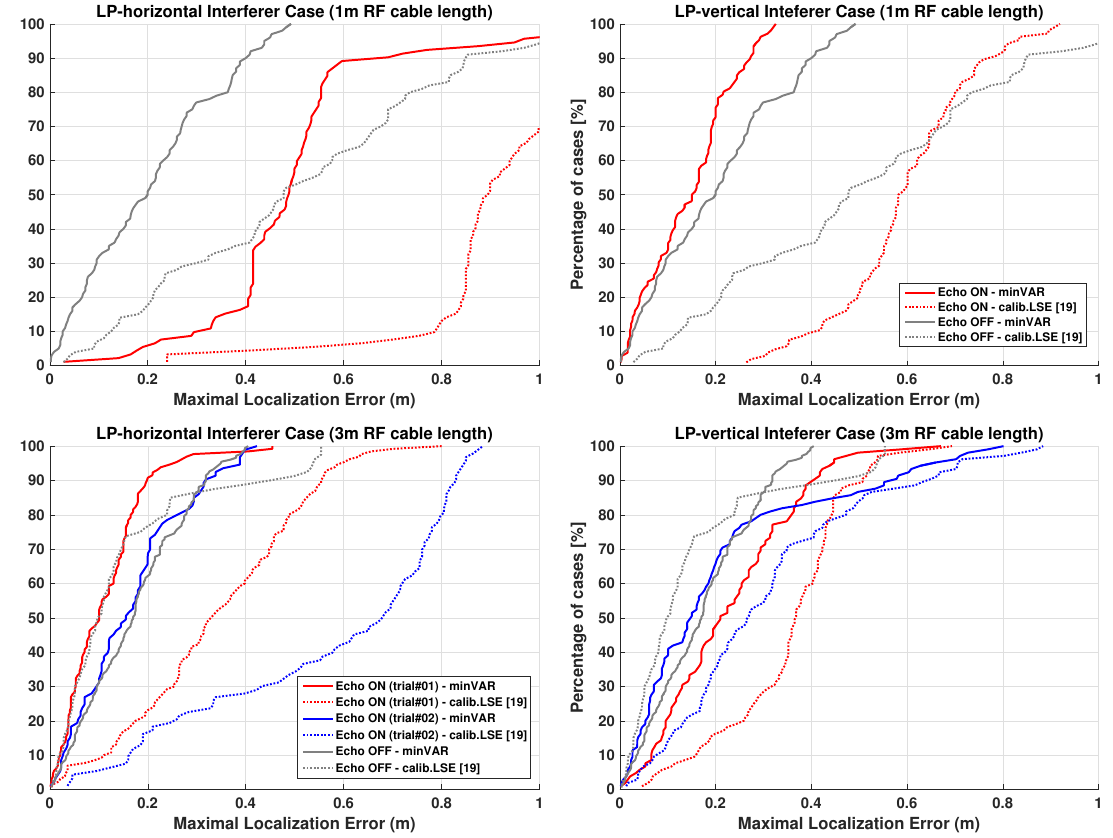
Figure 26. Tracking Error Results CDFs for all test cases: 1 m RF cable ( Above ) and 3 m RF cable ( Bottom